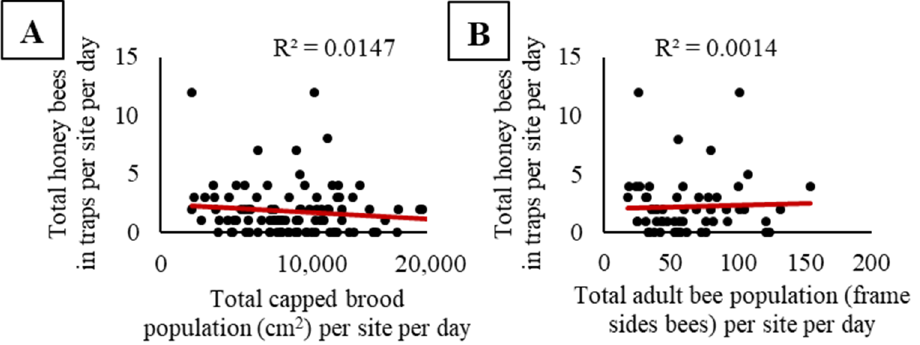
Figure 3. No significant relationships were found between honey bee activity-density (bees per trap per site per day) in pan traps with ( A ) total capped brood population at a site nor ( B ) total adult bee population at a site for each sampling day. Capped brood populations are from 2015 and 2016, while adult bee population was only measured in 2016.